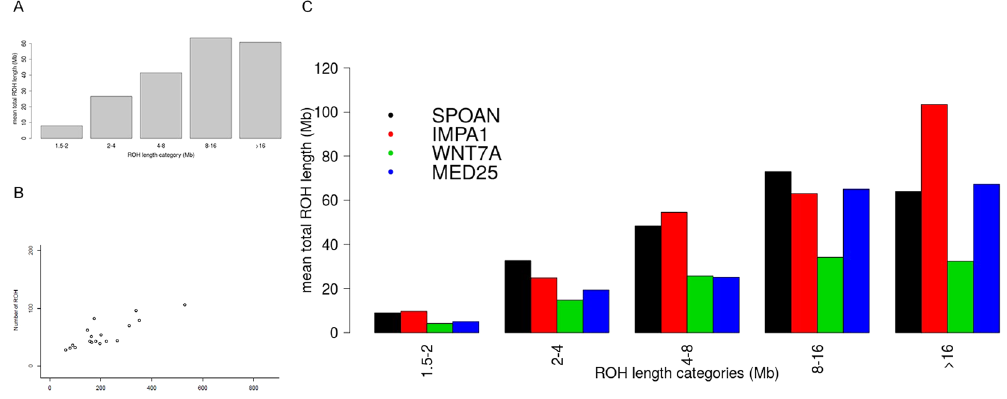
Figure 3. Molecular inbreeding estimates of ROH. ( A ) The mean of total length categories compared to the mean total ROH length for all affected individuals. ( B ) The total length in ROH compared to the number of ROHs for all affected individuals. ( C ) The mean of total length categories compared to the mean total ROH length, separated by disease